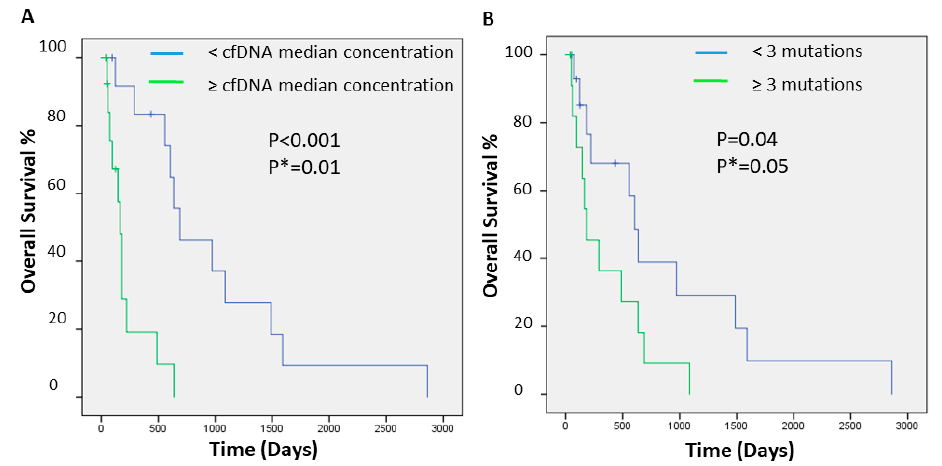
Figure 2. Kaplan–Meier curve of overall survival for HCC patients stratified by cfDNA concentration ( A ) and by number of mutations ( B ). Displayed are the Kaplan–Meier survival curves, and the p- values from the log-rank test. p *: p -value adjusted by tumor stage.